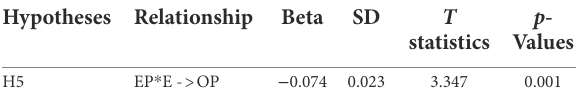
TABLE 5 Structural model assessment (direct relation effect and results).